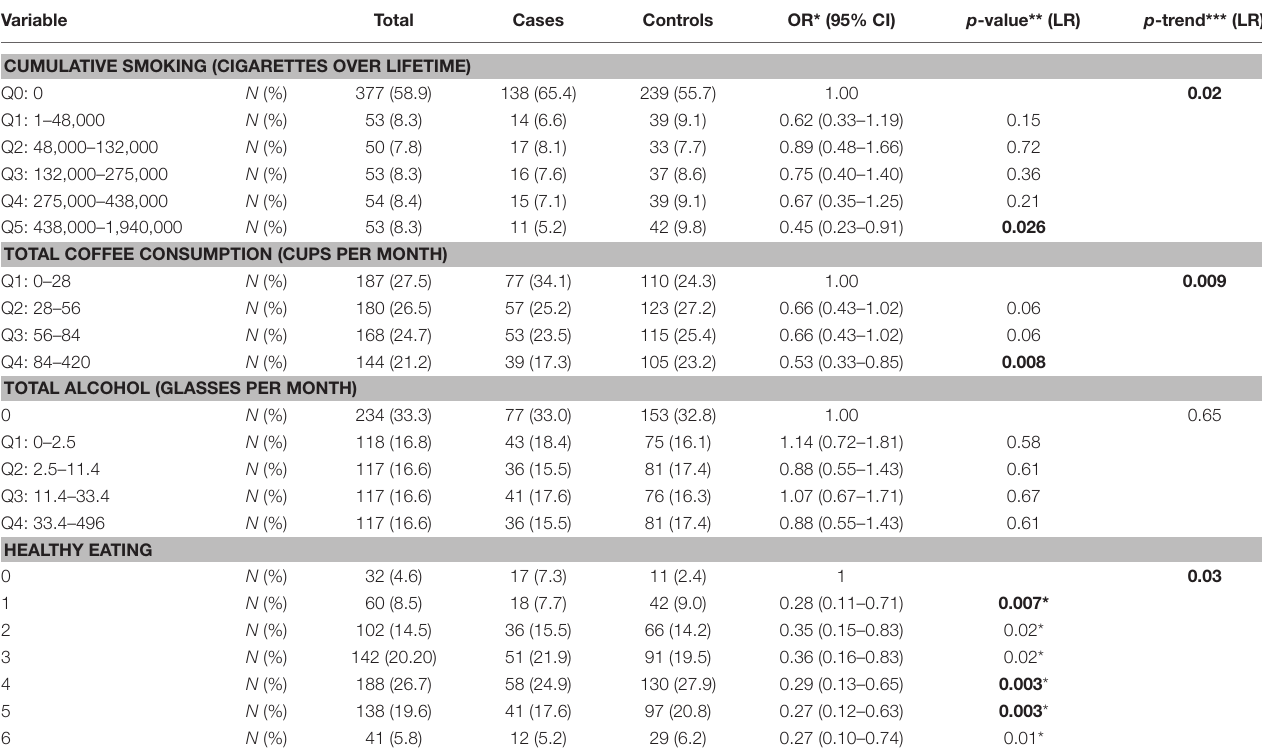
TABLE 2 | Lifestyle and previously reported exposure risk factors in Cypriot PD cases and controls. Variable Total Cases